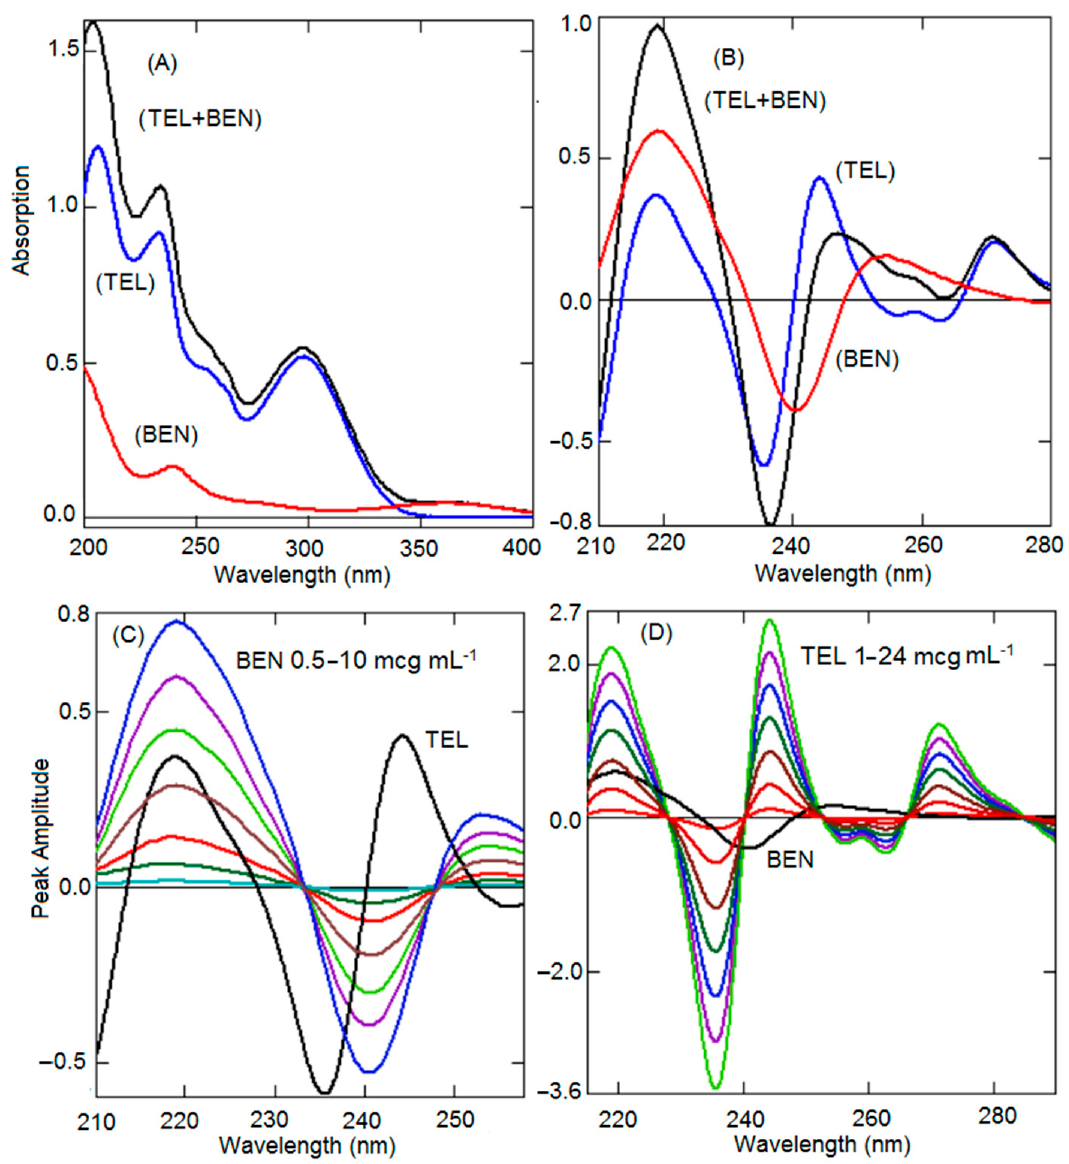
Figure 2. Zero-order UV absorption spectra of BEN (Red), TEL (Blue), and mixture (Black) ( A ). Second-order derivative spectra of BEN (Red), TEL (Blue), and mixture (Black) ( B ). Second-order derivative spectra of BEN (0.5–10 µ g mL − 1 ) ( C ). Second-order derivative spectra of TEL (1–24 µ g mL − 1 ) ( D ).